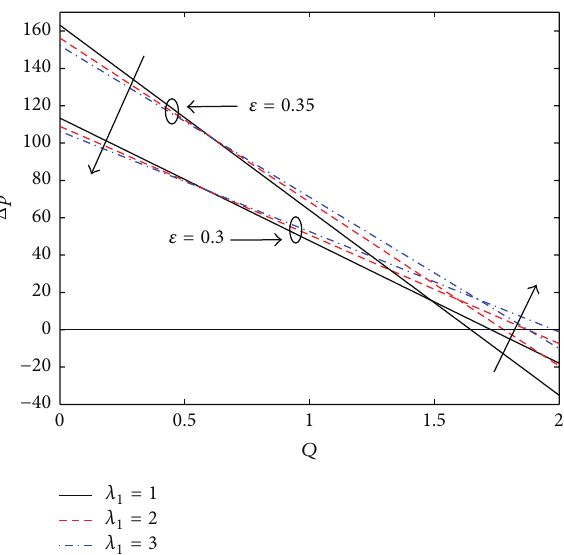
Figure 4: Pressure gradient 𝜕𝑝/𝜕𝑧 versus axial distance 𝑧 for differ- ent values of the heat parameter 𝛽 and the Grashof number Gr with = 1 , 𝛼 = 0.4 , 𝜀 = 0.35 , 𝜙 = 0.4 , and 𝑡 = 1 . 𝑄 = −2 , 𝜆 1 1